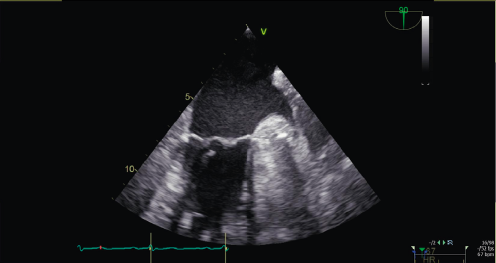
Figure 1: Transesophageal echocardiogram showing 0.9–1centimeter mitral valvular